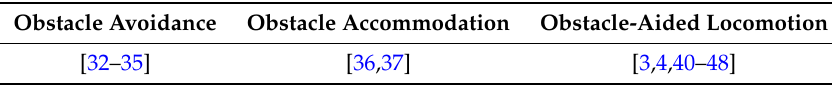
Table 1. Snake locomotion in unstructured